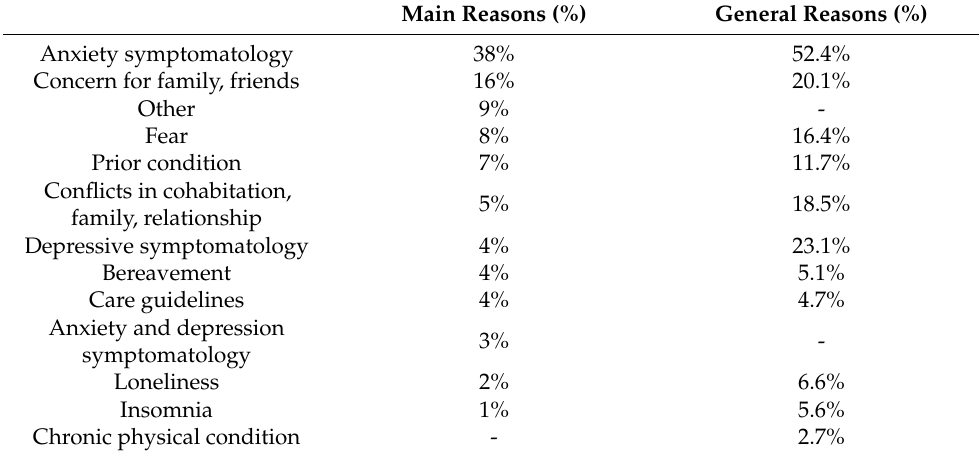
Table 1. Reasons for the calls.